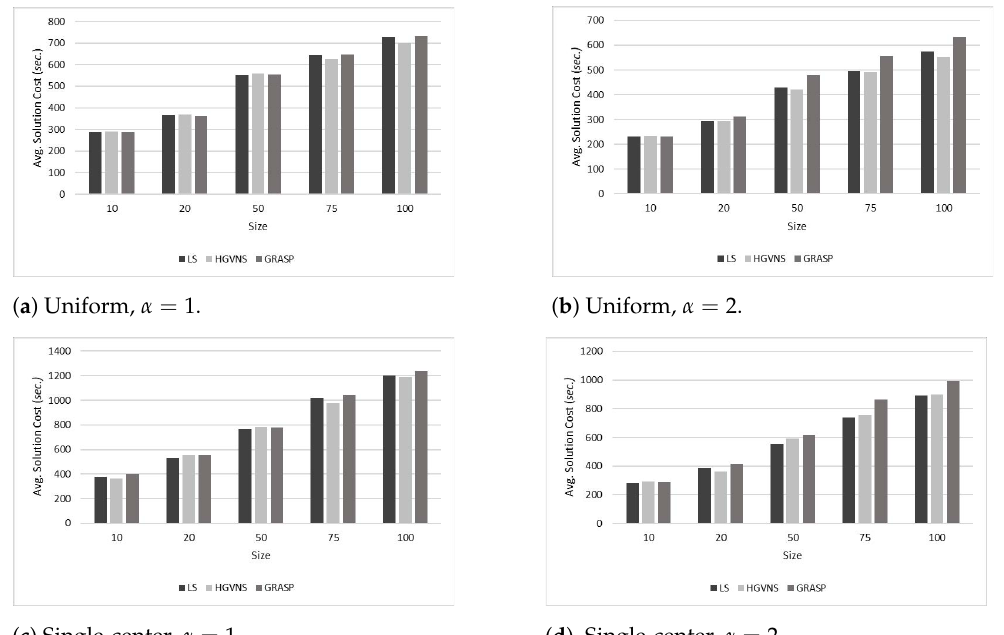
Figure 11. Comparison of the average solution cost (in sec s) obtained with the HCLS variant of the proposed GRASP, HGVNS [23], and LS [10] for instances of size 10, 20, 50, 75, and 100: ( a ) Uniform distribution, α = 1. ( b ) Uniform distribution, α = 2. ( c ) Single-centered distribution. α = 1 ( d ) Single-centered distribution, α =